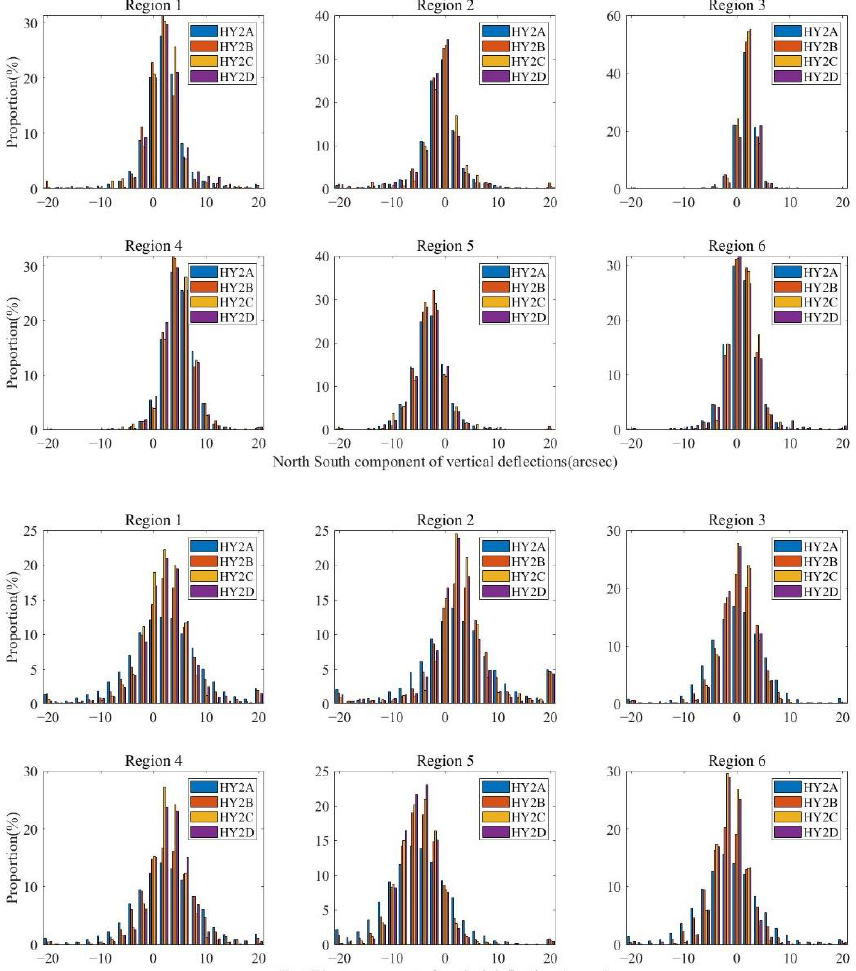
Figure 8. Distributional proportion of HY-2 directional components of vertical deflection over study regions: Region 1, North Pacific; Region 2, South Pacific; Region 3, Mid-Pacific; Region 4, Indian Ocean; Region 5, North Atlantic; Region 6, South Atlantic.